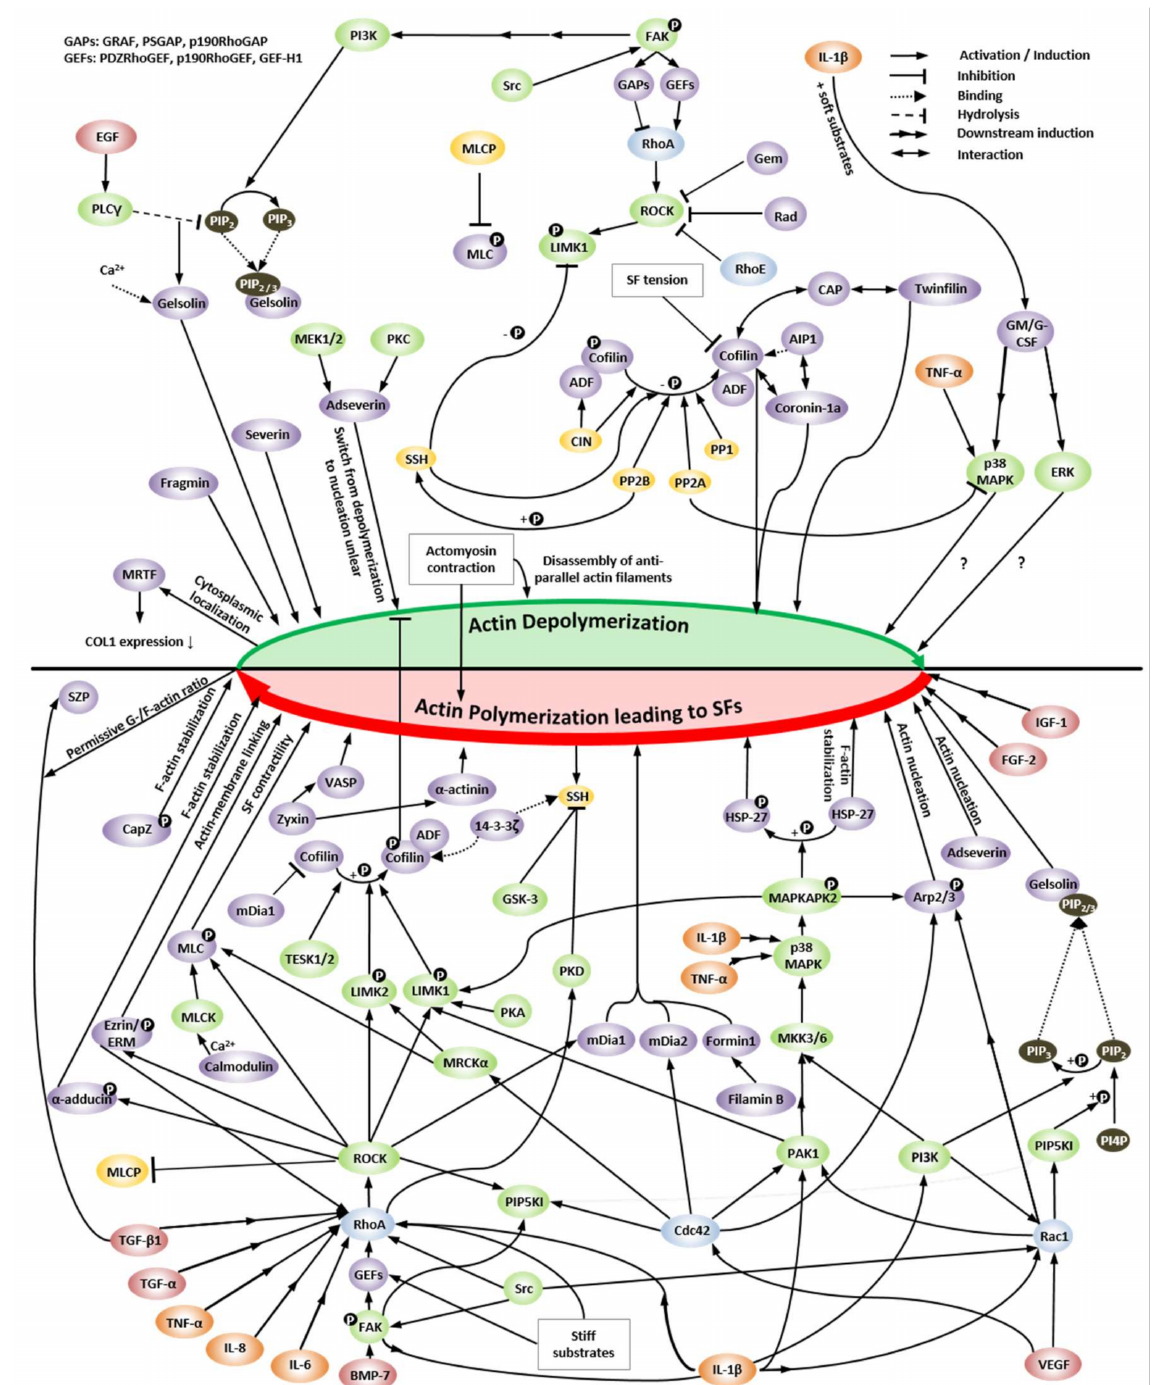
Figure 1. Regulation of actin dynamics. The relevant signaling pathways and molecules for regulating actin depolymeriza- tion (top, green half circle) compared to actin polymerization and/or stress fiber (SF) formation (bottom, red half circle), including upstream signaling through pro-inflammatory cytokines and growth factors as well as downstream signaling to actin-modulating proteins, e.g., cofilin and gelsolin, are illustrated. The legend in the upper right corner details the symbols used; the dotted arrow termed “binding” describes the binding of a substance, which might cause either inhibition or activa- tion. Details are specified in the text. Abbreviations: ADF: actin-depolymerizing factor, AIP1: actin-interacting protein 1, Arp2/3: actin-related protein 2/3, BMP-7: bone morphogenetic protein 7, CAP: cyclase-associated protein, CIN: chronophin, COL1: type I collagen, DEX: dexamethasone, EGF: epidermal growth factor, ERK: extracellular signal-regulated kinase, ERM: ezrin/radixin/moesin, FAK: focal adhesion kinase, FGF-1: fibroblast growth factor 1, FGF-2: fibroblast growth factor 2, GAPs: GTPase-activating proteins, GEFs: guanine-nucleotide exchange factors, G(M)-CSF: